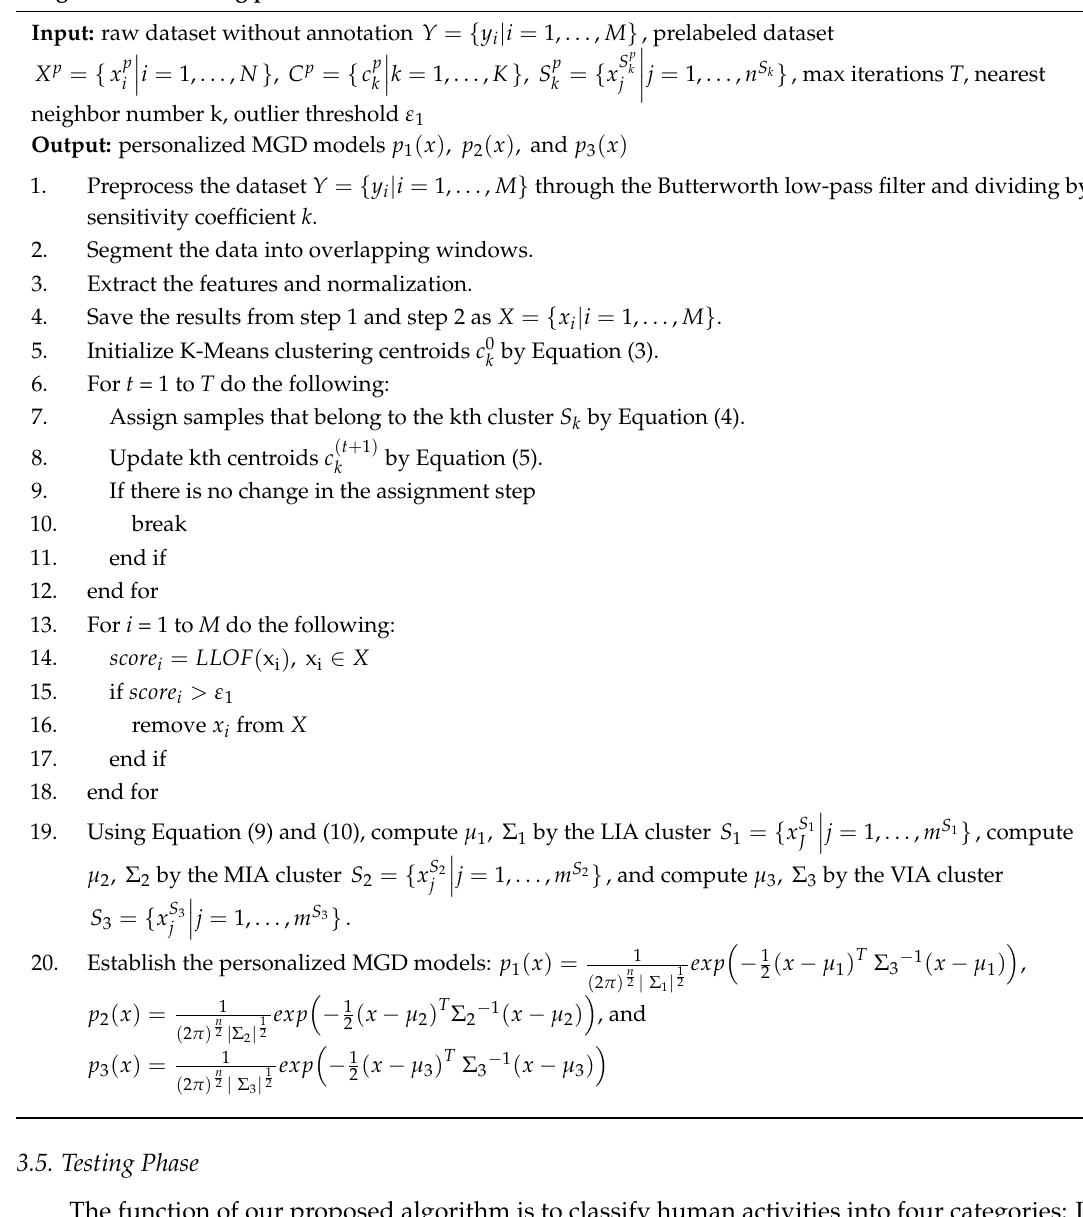
Algorithm 1 Training